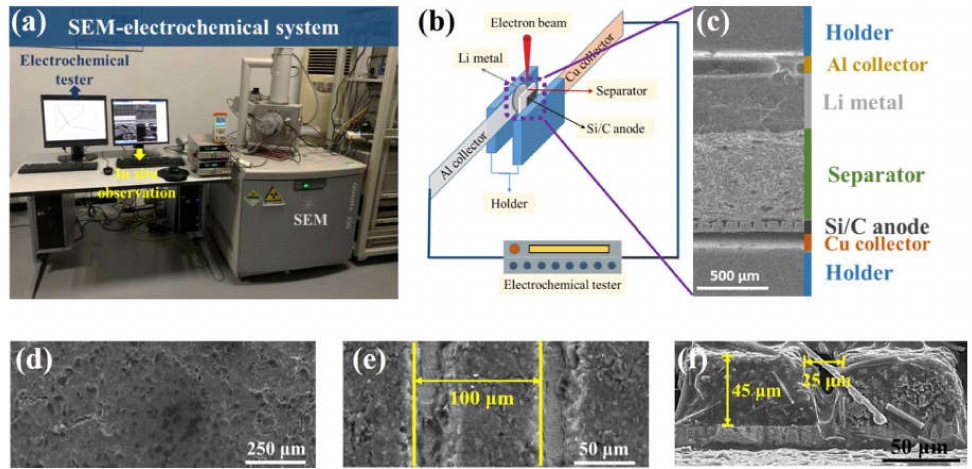
Figure 1. ( a ) The photograph of the SEM-electrochemical system. ( b ) Schematic drawing of in situ SEM observation for the cross-section of the Li-Si/C battery. ( c ) Low-magnification SEM image of the Li-Si/C battery for the in situ experiment. SEM images of ( d ) unstructured and ( e ) 3D-line-structured Si/C composite material. ( f ) The thickness of Si/C composites and the width of the